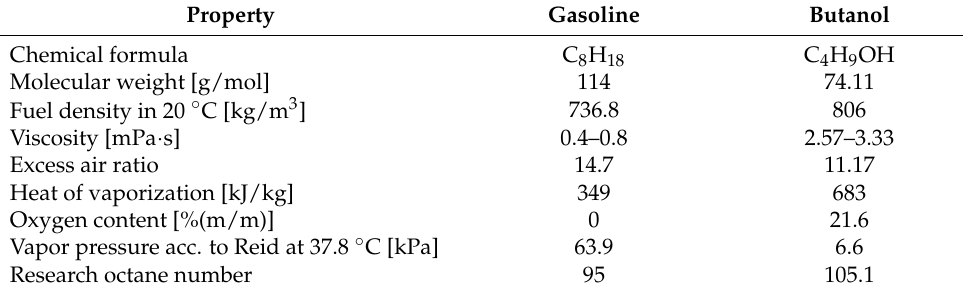
Table 1. Main properties of gasoline and butanol [18,19,25].